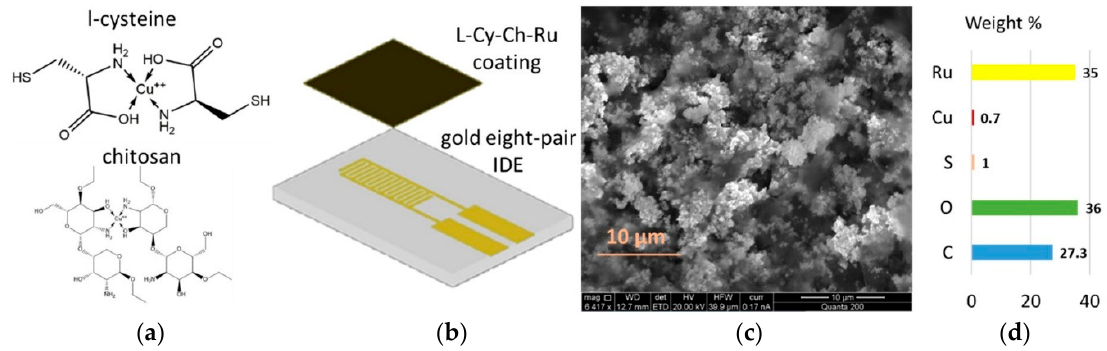
Figure 1. ( a ) Sketched model for chelation between L-cysteine (above) and chitosan (below), selective polymers, and Cu ions using Chem3D. ( b ) Schematic drawing of the IDE sensor and L-Cy-Ch-Ru thick film. ( c ) SEM image of the coating and ( d ) its elemental composition (%) measured with the XRF after the interaction with Cu